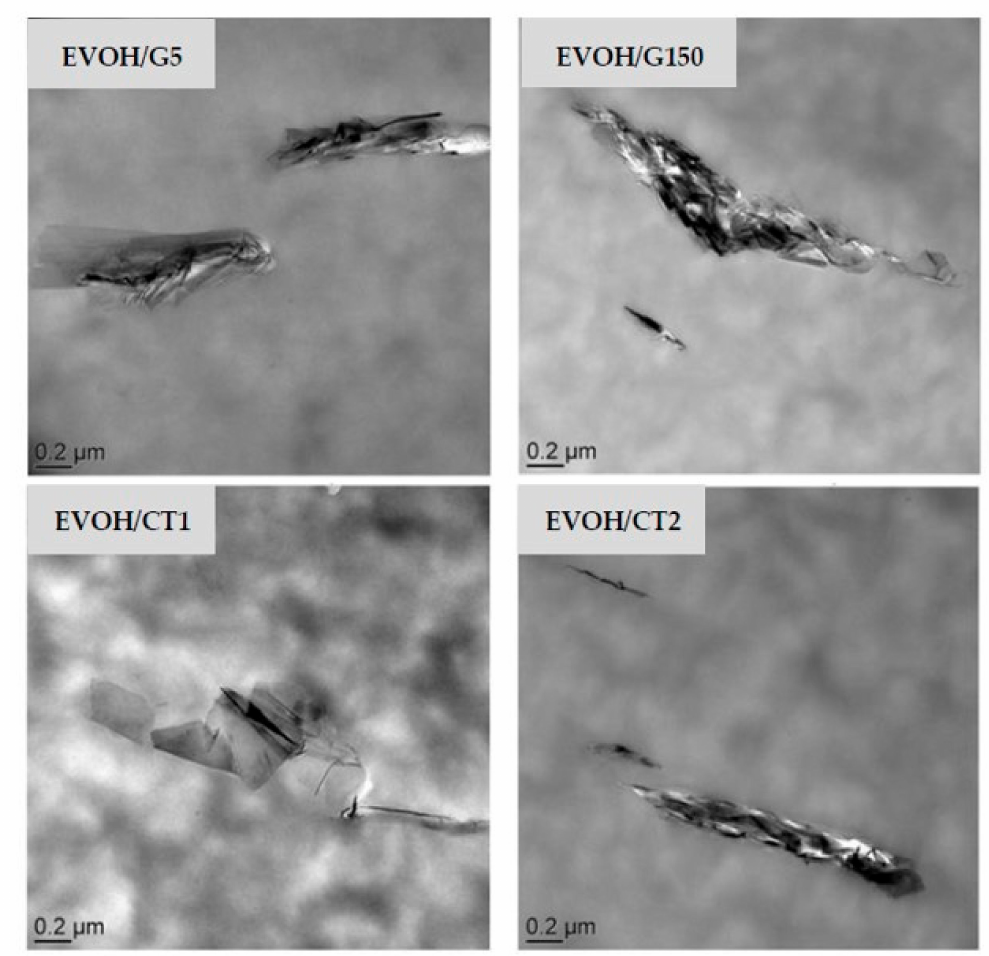
Figure 2. TEM micrographs at high magnifications of the studied nanocomposites as a function of the filler type (filler rate = 2 wt%).